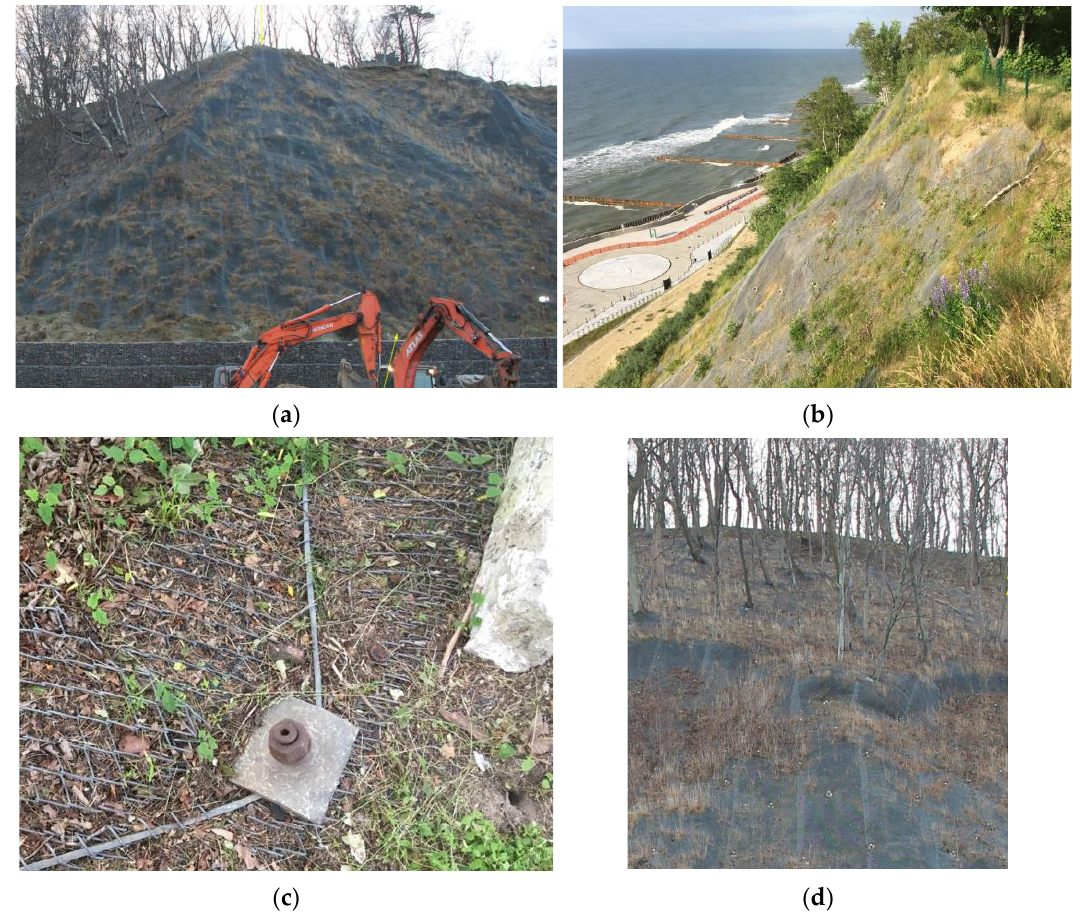
Figure 2. Cliff slope in Svetlogorsk during construction ( a ) and after completion ( b ) of the slide protection, which includes a geomat layer armoring of landslide slopes ( c ) and flexibly adjusted ( d ) to existing tree cover.